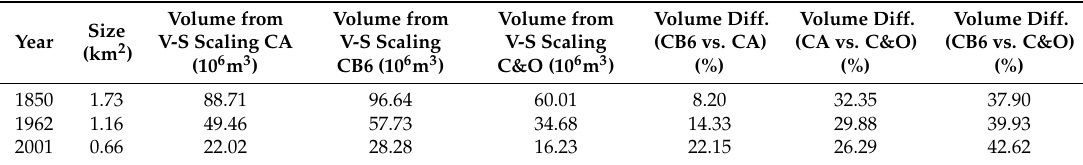
Table 3. Difference in the V-S scaling of YAN between the cellular automata model and six glaciers in the Cordillera Blanca [19,65].